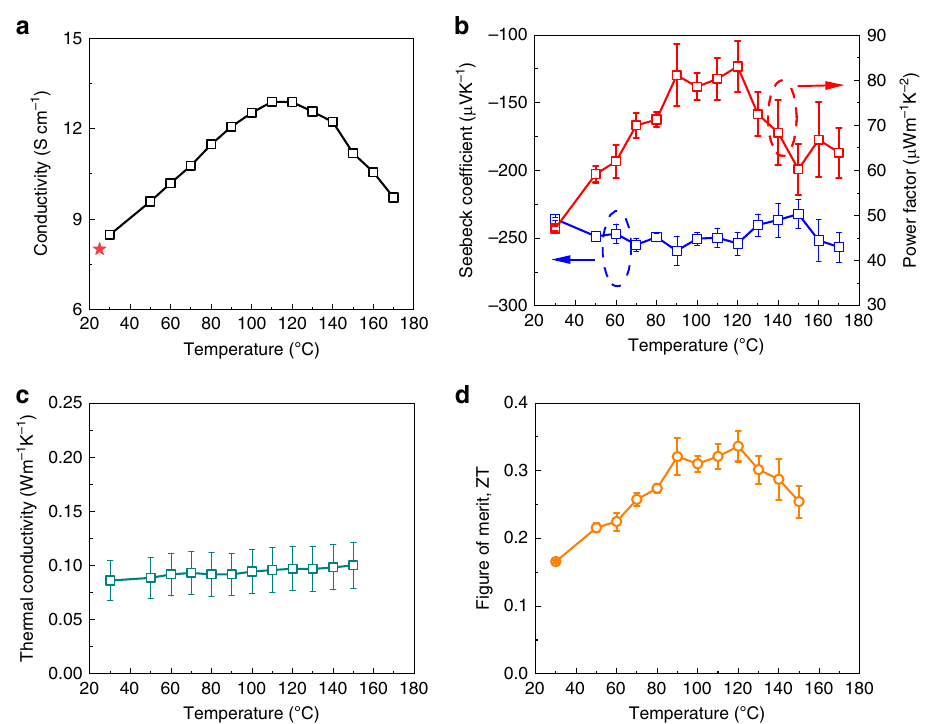
Fig. 5 Temperature dependent thermoelectric parameters. a electrical conductivity (the red star represents the conductivity after cooling down to 25 °C), b Seebeck coef fi cient (blue) and power factor (red), c in-plane thermal conductivity and d fi gure of merit, ZT at various operating temperatures for the doped PTEG-2 fi lm at a 5 wt% doping concentration. Error bars ( b , c ) represent the standard errors of Seebeck coef fi cient and thermal conductivity obtained by best- fi ts; error bars ( d ) represent the corresponding calculated deviations of ZT